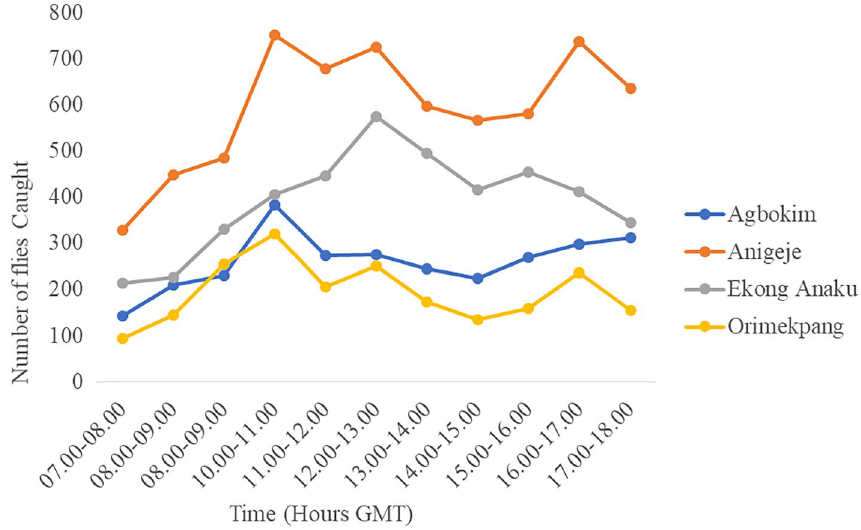
Figure 2. Diurnal biting rate of S. damnosum complex in the four study sites.